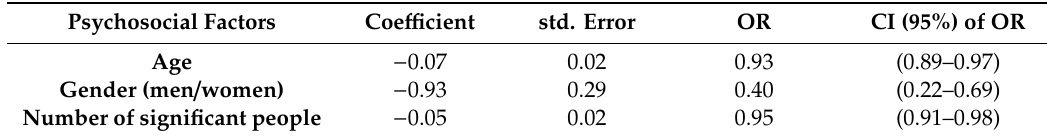
Table 3. Logistic regression for psychosocial factors: age, gender, and number of significant people. Odds ratio